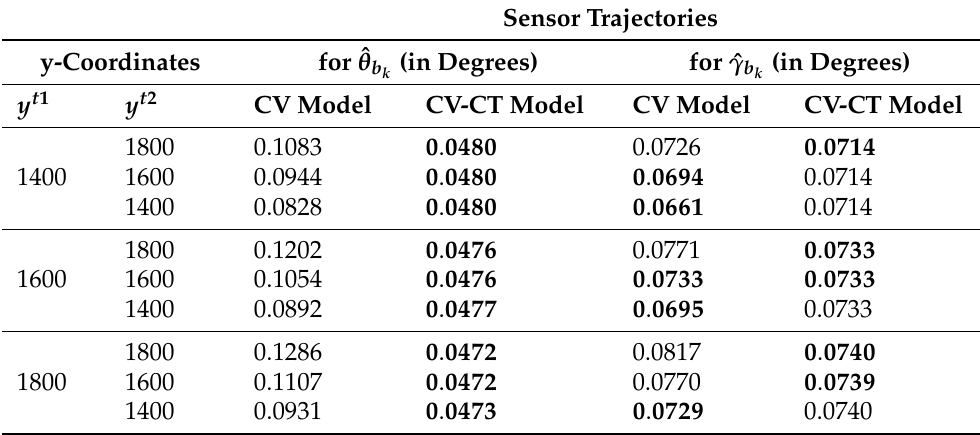
Table 2. PCRLB (in degrees) for θ b true locations of the 2 targets of